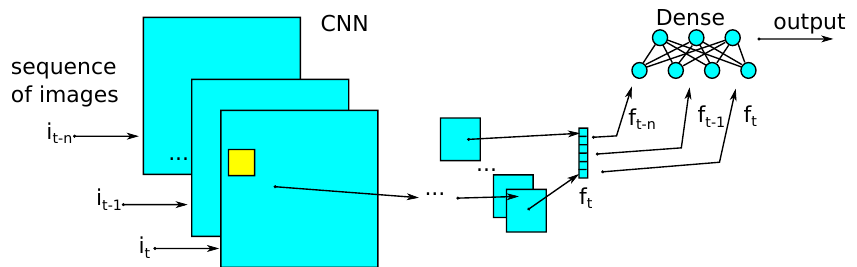
Figure 7. Classification model combining a convolutional network and dense network, to classify using adjacent frames results, called the